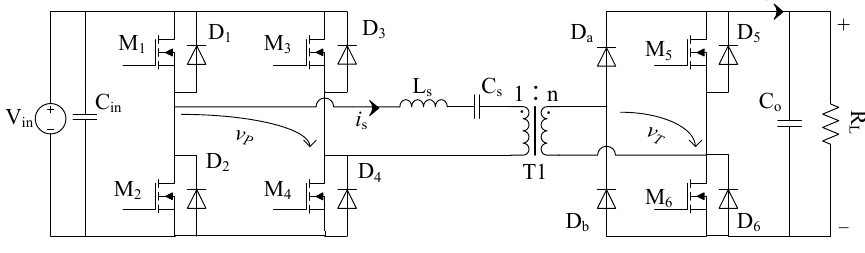
Figure 1. A secondary-side phase-shifted resonant